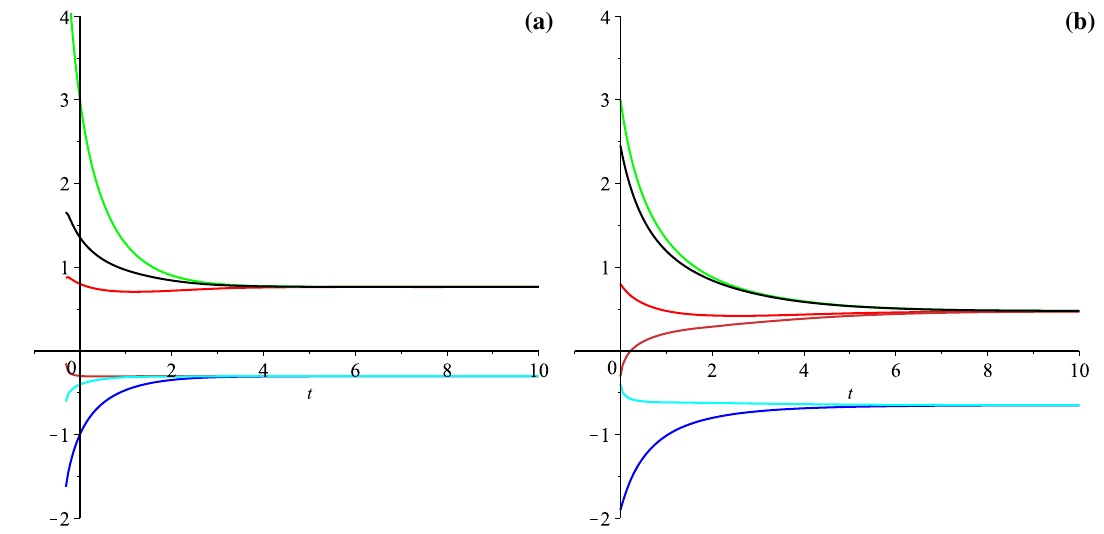
Fig. 3 Typical evolution curve for stable anisotropic [ 3 + 3 ] a and [ 4 + 2 ] b exponential solutions with broken symmetry in both subspaces in the D = 3 case (see the text for more